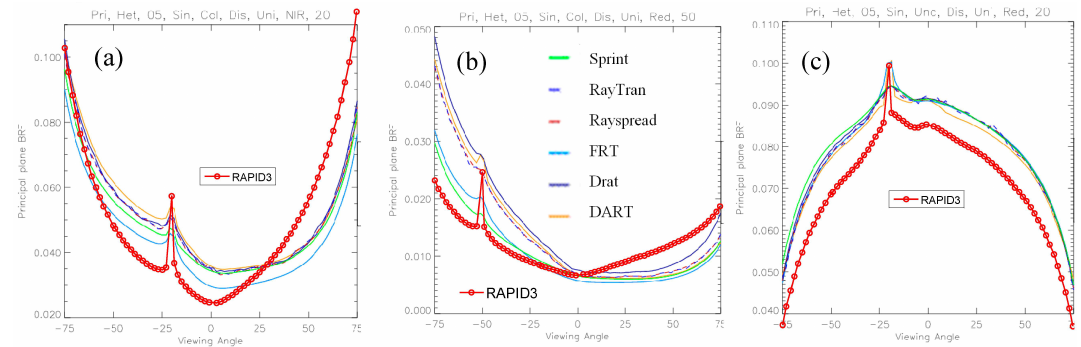
Figure 14. Comparisons of HET05 single scattering BRF results in the principal plane (brfpp) with other 3D models from the RAMI online: ( a ) leaf scattering in the NIR band at SZA 20°; ( b ) leaf scattering in the red band at SZA 50°; ( c ) soil scattering in the red band at SZA 20°.